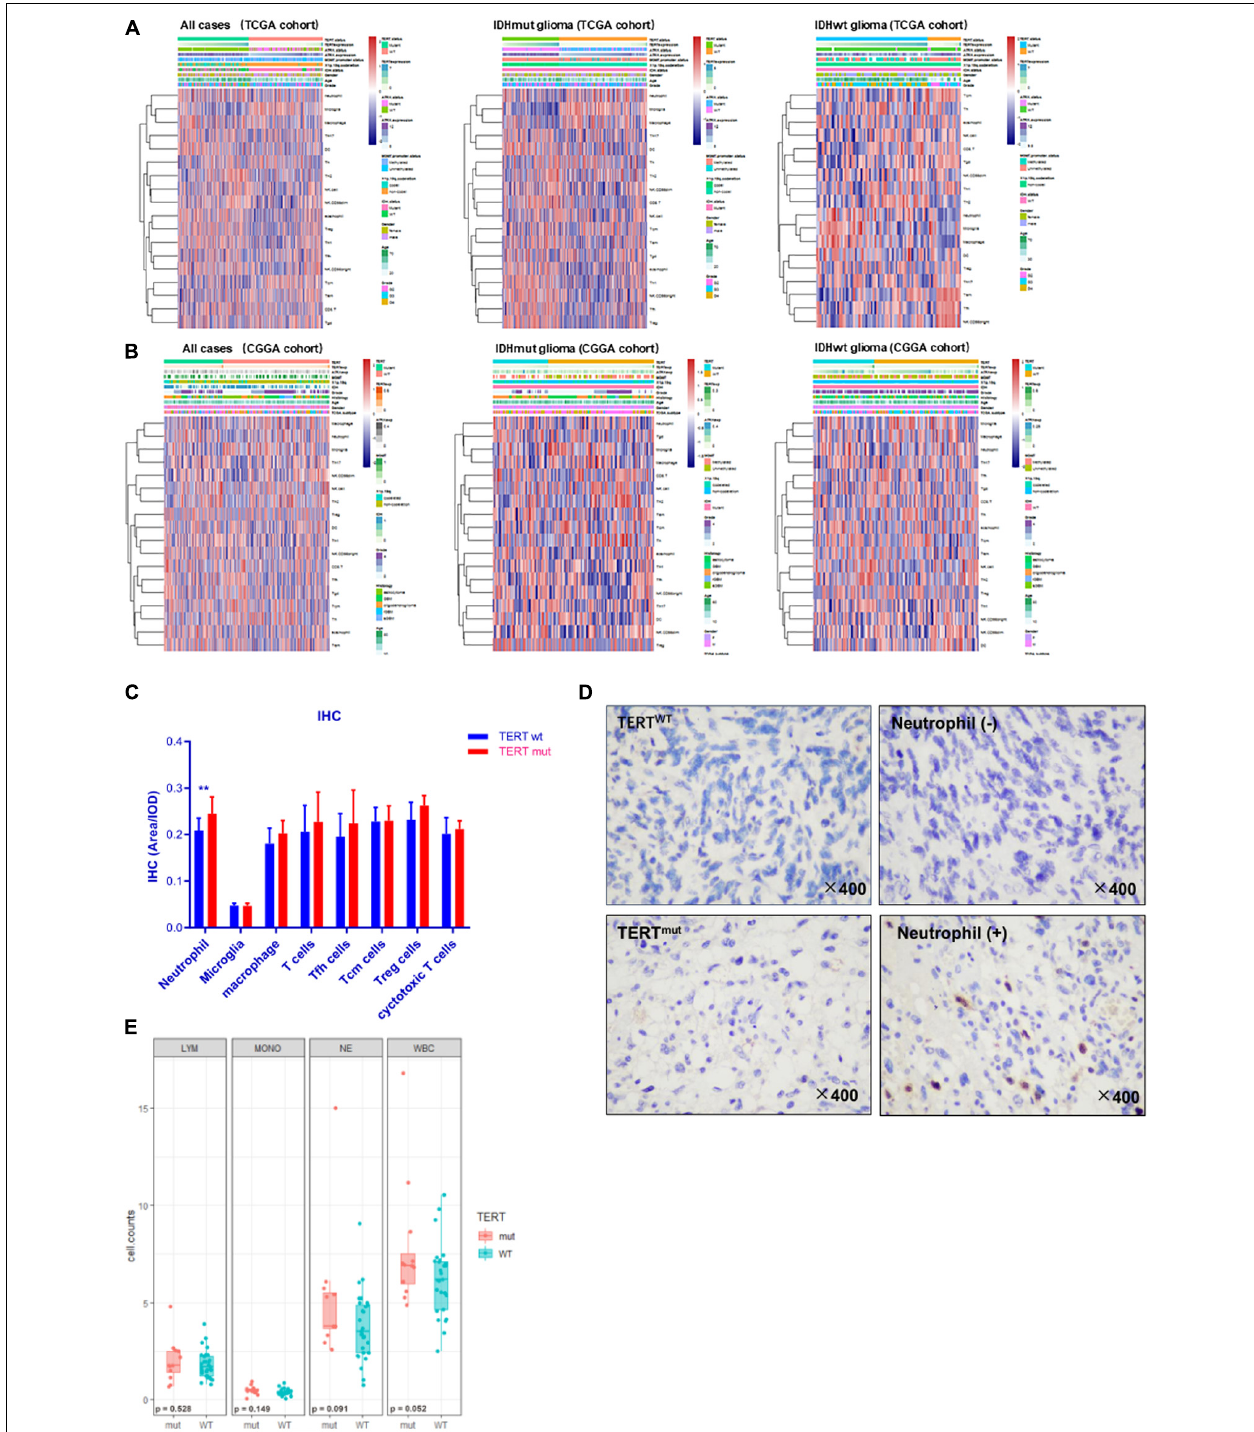
FIGURE 3 | Immune cell enrichment in gliomas according to TERT status. Samples were divided into a TERT mutant ( TERT mut) group and TERT wild-type ( TERT wt) group. All cases, IDH mutant and IDH wild-type cases from TCGA cohort (A) . The same subgroup gliomas from the Chinese Glioma Genome Atlas (CGGA) cohort (B) . Immunostaining results of multiple immune cells according to TERT mutation. (C) Immunohistochemistry result among 49 IDHwt gliomas. (D) Immunohisto- chemical staining showed that neutrophils increased with TERT mutation in IDHwt gliomas, –, Lower than the mean value; +, higher than the mean value. (E) Immune cell counts of peripheral blood according to TERT mutation in IDHwt glioma; LYM, lymphocytes; MONO, monocytes; NE, neutrophils; WBC, total leukocytes; significant p < 0.05.